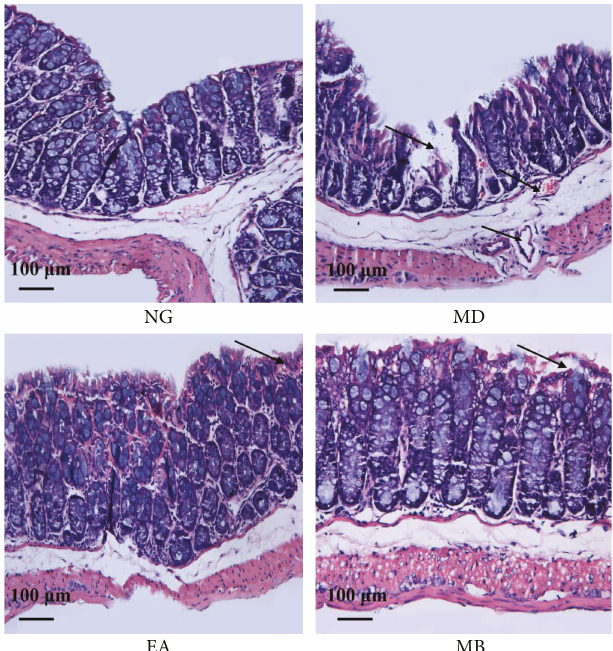
Figure 3: Pathological morphology of colon tissues was observed by hematoxylin-eosin staining. The NG showed continuous structure of mucosal epithelium and complete intestinal glands. Damaged mucosa, disordered glandular structure, and hyperemia were observed in the MD group. And the EA and MB showed greatly improved histopathological conditions after receiving EA and MB treatments. NG: normal group; MD: model group; EA: electroacupuncture group; MB: moxibustion group. Black arrow: representative features of colonic tissue (magni fi cation: 200x, scale bar =100 micron).